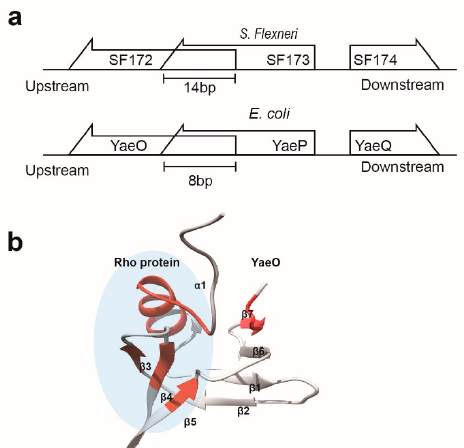
Figure 3. Structure and molecular interaction of SF172/YaeO ( a ) Schematic diagram showing gene arrangements in the sf172/yaeO-containing operons. ( b ) Ribbon presentation of the YaeO structure (PDB ID 1SG5), where the Rho-binding sites are colored red. Note that the complex structure is not available, and the binding site was determined by NMR spectroscopy [15].